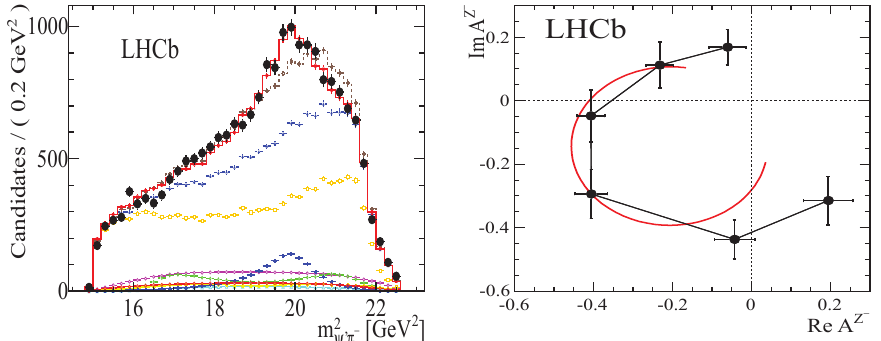
Figure 3. (Left) Distribution of m 2 , where black dots represent data, the red solid and brown ψ (2 S ) π − dashed lines indicate the total fi t with and without the Z (4430) − component. (Right) Fitted values of Z (4430) − amplitude in six m 2 bins shown in an Argand diagram. Figure adopted from ψ (2 S ) π −